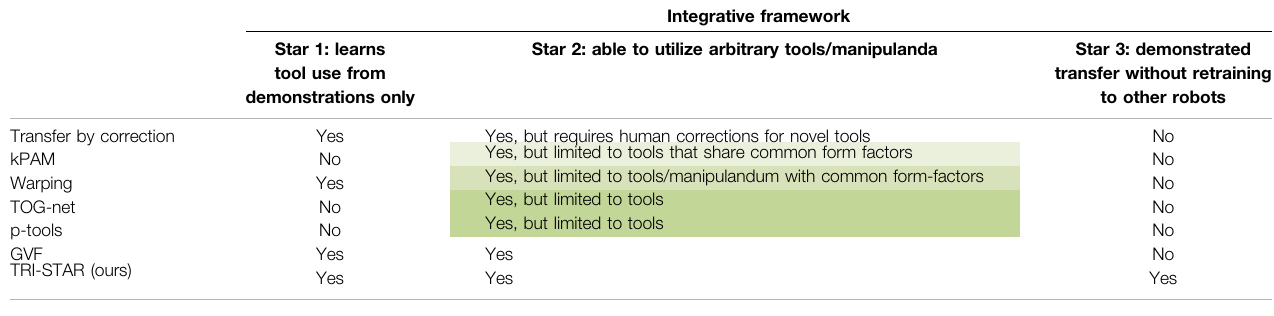
TABLE 2 | Comparing functionality. The table showed that TRI-STAR is an integrative framework with the most demonstrated functionality.